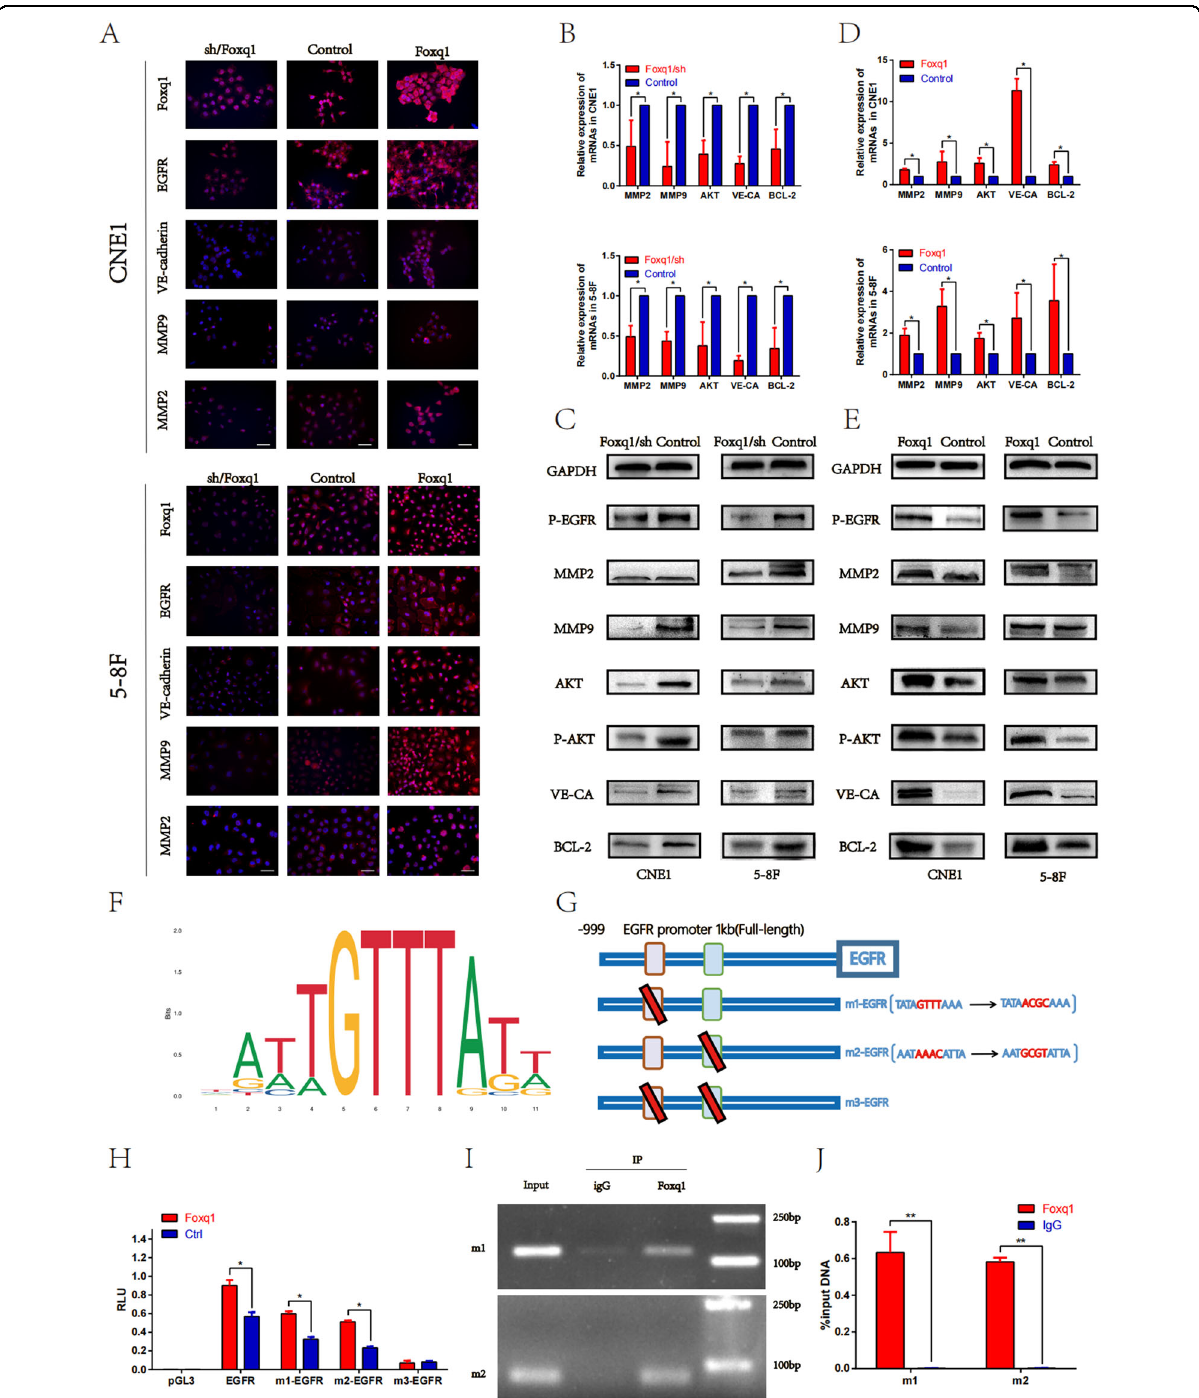
Fig. 4 Foxq1 promotes the EGFR signaling pathway and VM-related genes through a direct binding to the EGFR promoter. A Immuno fl uorescence staining of Foxq1,EGFR,VE-cadherin,MMP2, and MMP9 in Foxq1 dysregulated 5 – 8F, and CNE1; Scale bars represent 50 μ m. qRT- PCR (above) and western blot (down) were used to monitor the expression of EGFR signaling pathway and VM-related genes in 5 – 8F, and CNE1 after Foxq1 downregulation ( B , C ) or overexpression ( D , E ). F The binding motif of Foxq1 from the JASPAR database. G A diagram showing the relationship of full-length (FL) and mutant EGFR promoters. H 293 T cells were transfected with Foxq1 overexpressing or control vector. The luciferase reporter gene vectors carrying FL or EGFR promoter mutant were co-transfected respectively for 36 h. Then, the dual-luciferase activity was detected. I The CHIP-PCR assay was used to assess the binding of Foxq1 to the EGFR promoter region. J Anti-Foxq1-pulled down chromatins were analyzed by qRT- PCR. Data are presented as mean ± SD of three independent